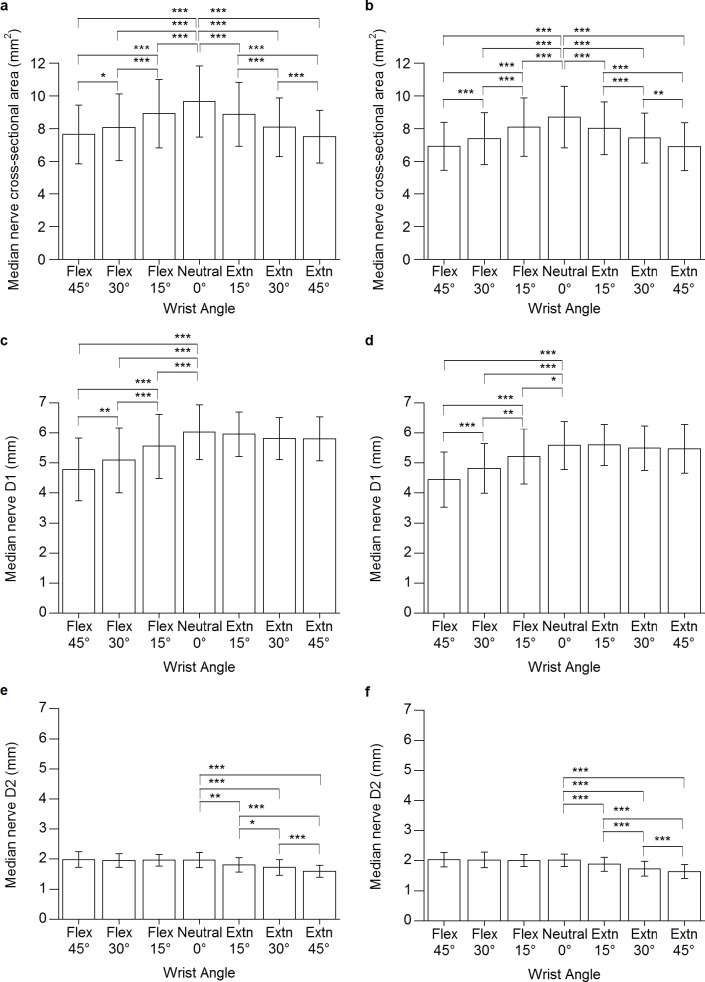
Median nerve cross-sectional area at different wrist angles.(A) Dominant hand. (B) Nondominant hand; Median nerve longitudinal diameter (D1) at different wrist angles (C) Dominant hand. (d) Nondominant hand; Median nerve vertical diameter (D2) at different wrist angles (E) Dominant hand (F) Nondominant hand. Extn, extension; Flex, flexion. ∗P < .05, ∗∗P < .01, ∗∗∗P < .001.